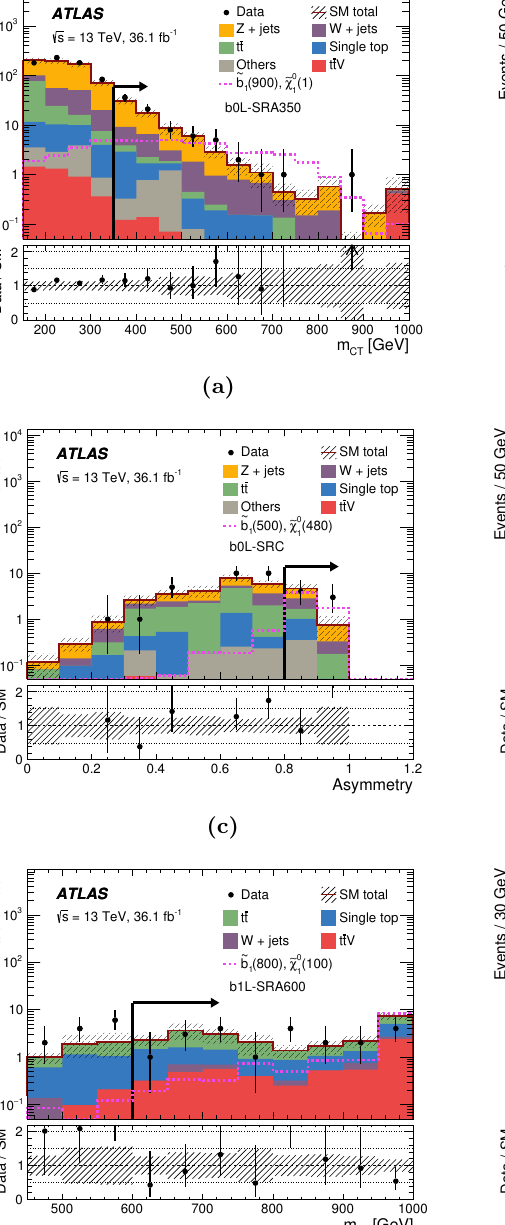
; E miss )] in b0L-SRB, (c) A in 1 (cid:0) 4 T